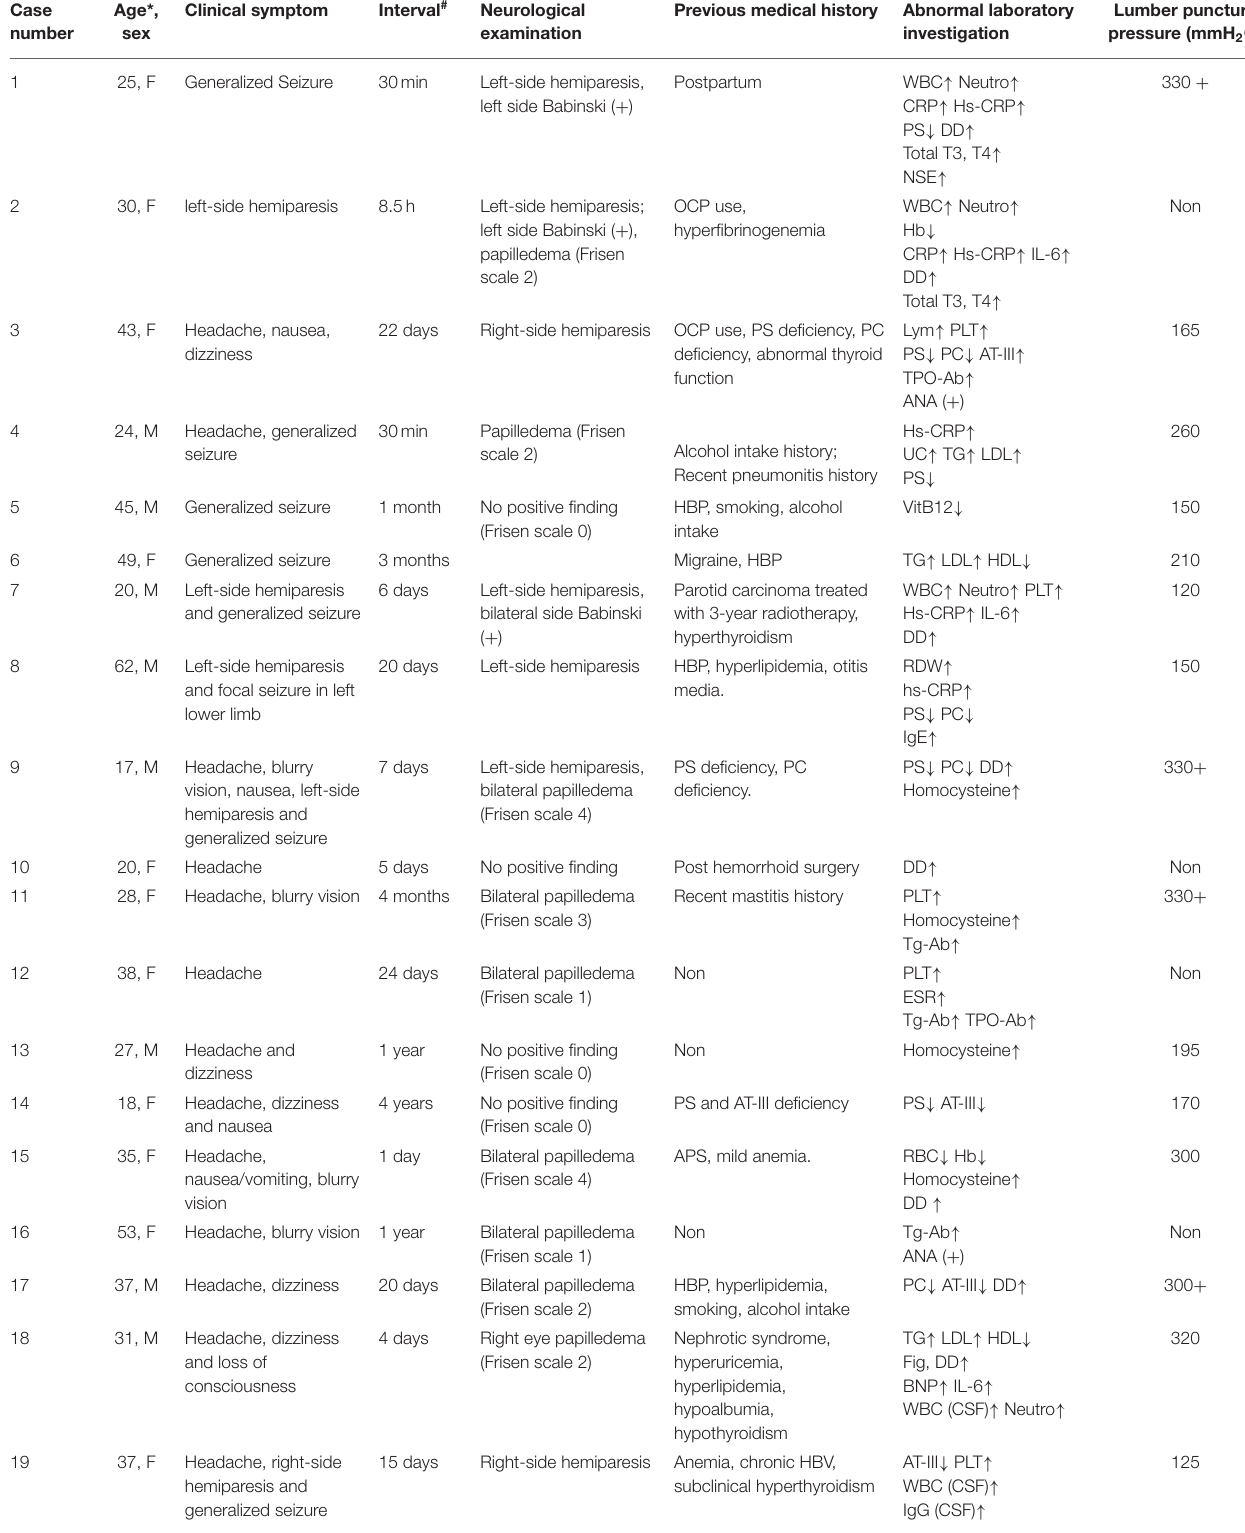
TABLE 1 | Clinical baseline information of the patients with CCVT on their admissions. Case number